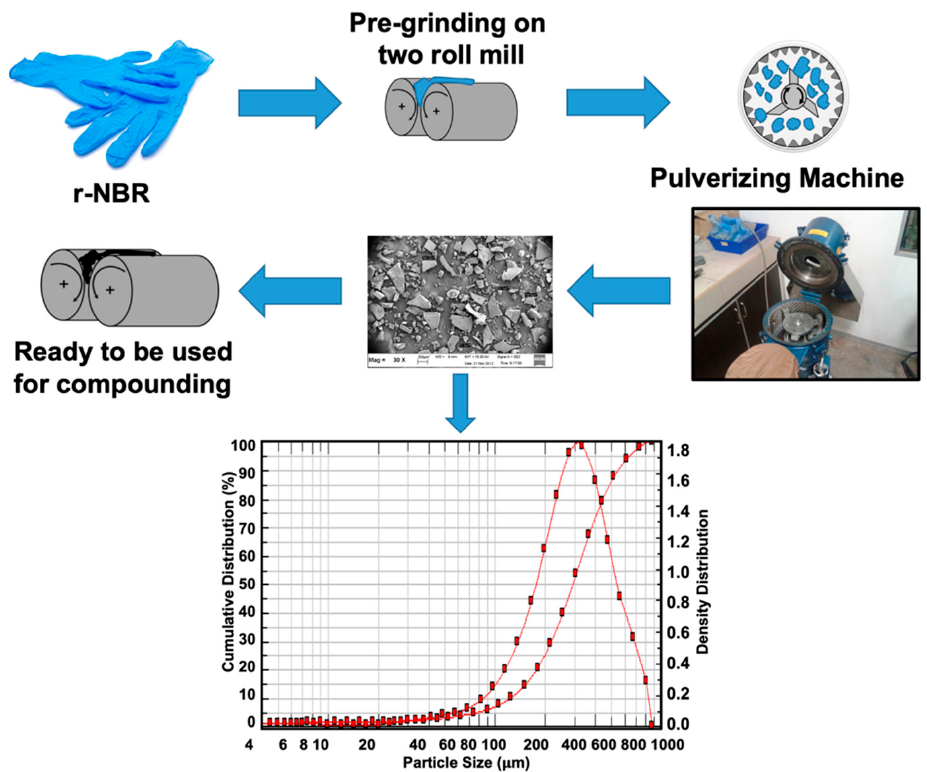
Figure 1. Preparation steps of r-NBR prior to blending with NR.